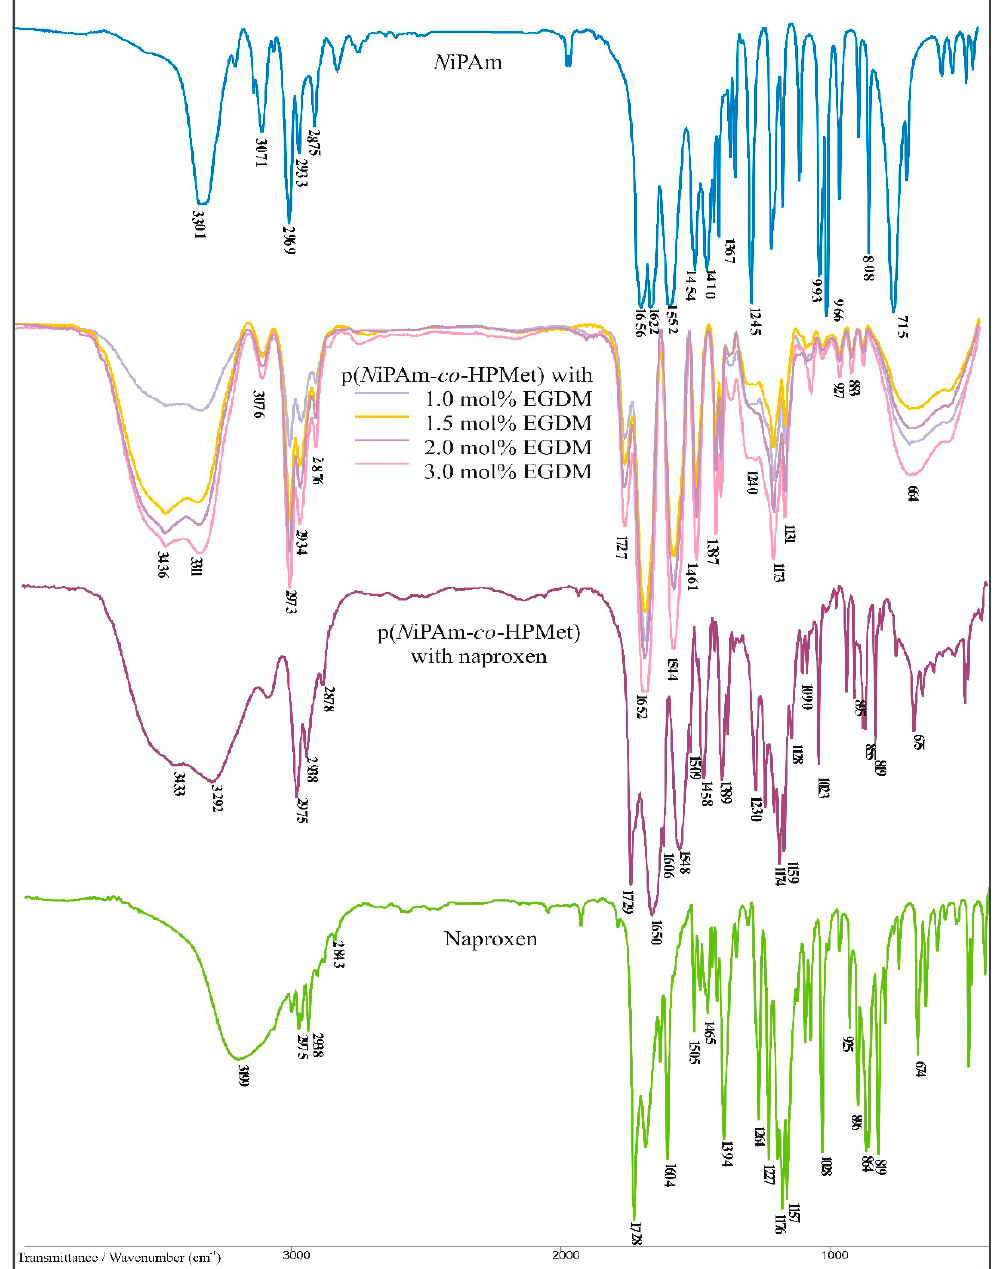
Figure 3. FTIR spectra of monomer N iPAm, synthesized p( N iPAm -co- HPMet) hydrogels with 1.0, 1.5, 2.0 and 3.0 mol% of EGDM, p( N iPAm -co- HPMet) hydrogel with 1.0 mol% of EGDM with incorporated naproxen and naproxen.